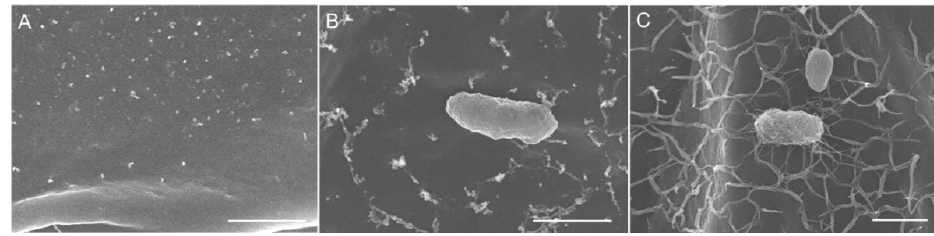
Figure 5. SEM images of L. aequinoctialis fronds surfaces of the aseptic control ( A ) and the F-183 ( B ) and TBR-22 ( C ) co-cultures. Bars, 1.0 μm. ( B ) and TBR-22 ( C ) co-cultures. Bars, 1.0 µ